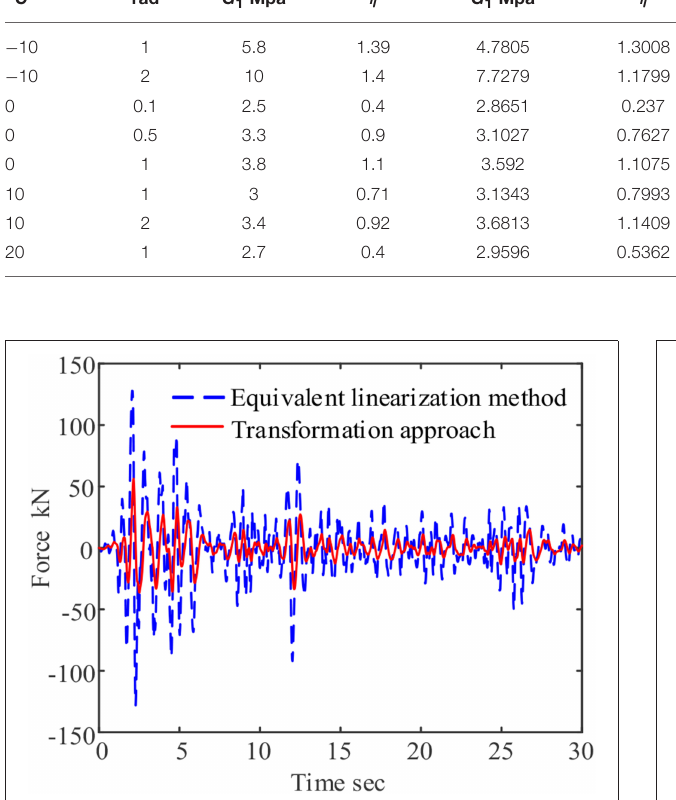
FIGURE 3 | Force-time curve of viscoelastic damper under seismic load (assuming working frequency is 0.2Hz).